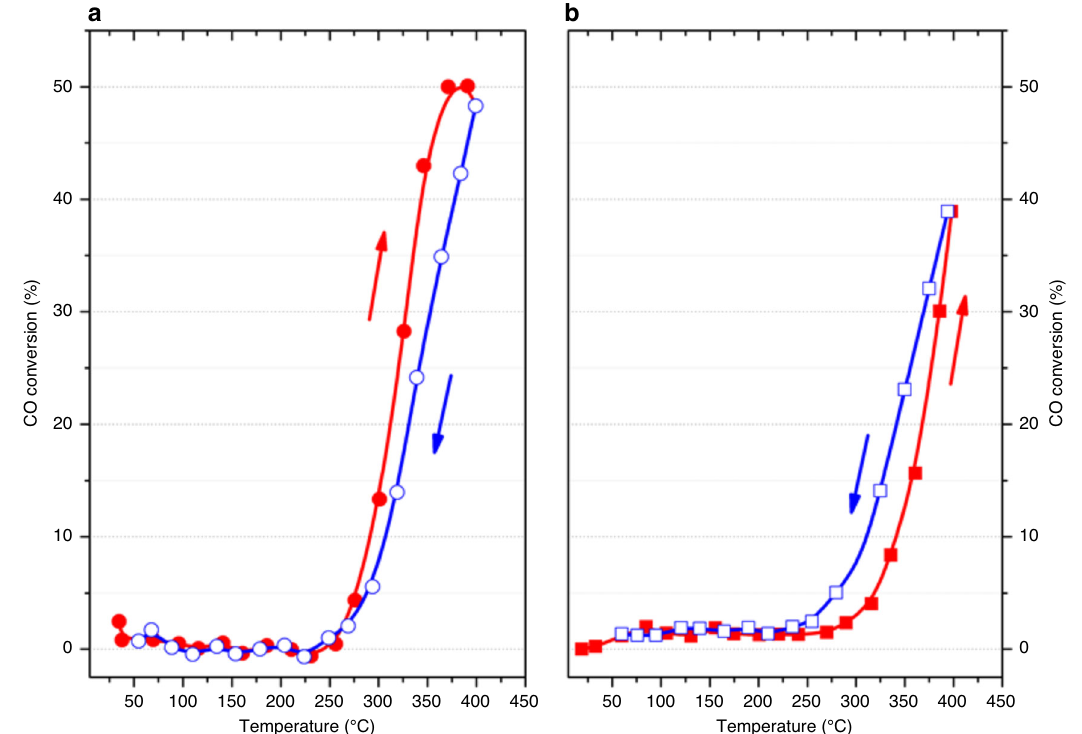
Fig. 3 Catalytic activity during CO oxidation reaction. CO conversion as function of temperature for a the cuboctahedra and b cubes showing the inverse and normal hysteresis loops behaviours, respectively. The red symbols indicate the heating ramps, while the blue symbols indicate the cooling